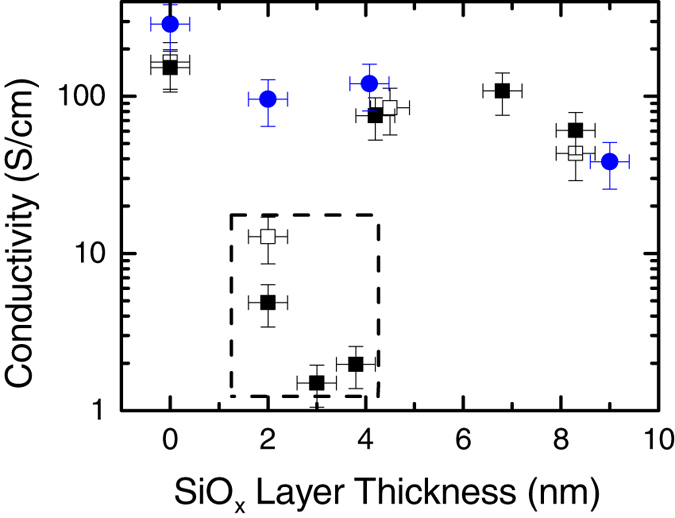
Conductivity of the superlattices as a function of the SiOx layer thickness. Conductivity vs. SiOx layer thickness of the a-IGZO/SiOx superlattices and ZnO:Al/SiOx superlattices.(■) a-IGZO/SiOx superlattices on glass substrate, (□) a-IGZO/SiOx superlattices on Al2O3, () ZnO:Al/SiOx superlattices. The low thickness SiOx layers exhibiting lower conductivities are highlighted by the dashed box.